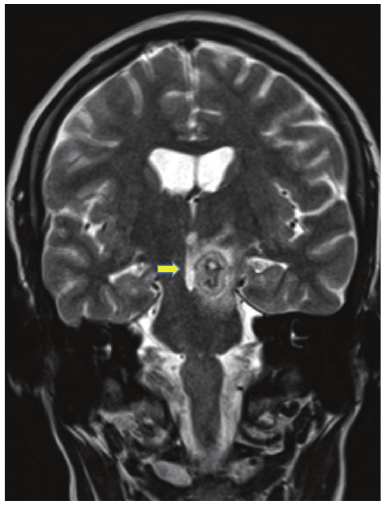
Figure 7: Tuberculoma after 2 months (frontal view).